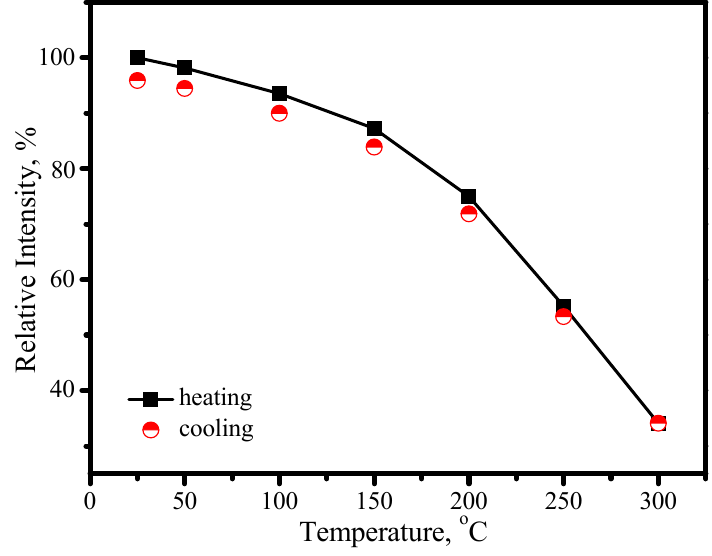
Figure 23. Luminescence intensity of (Sr a function of